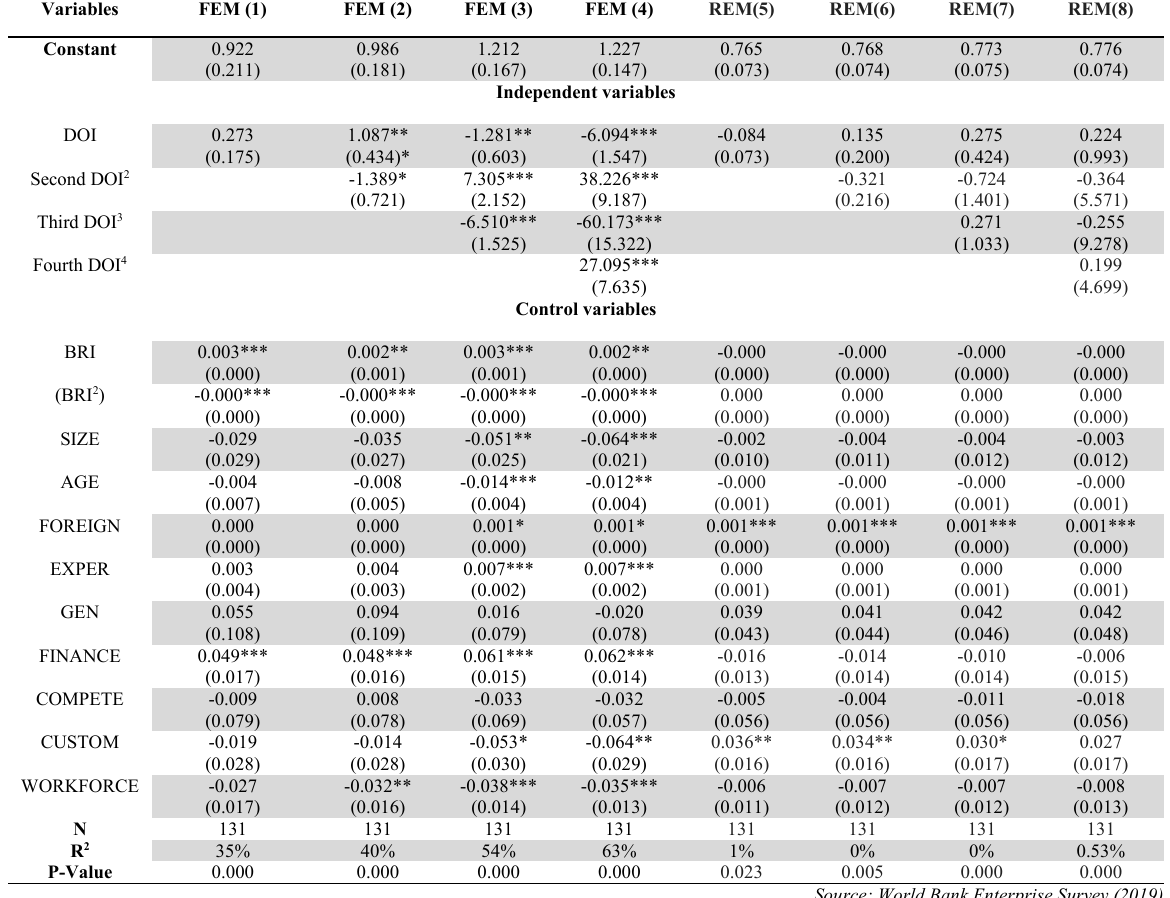
The regression results for FEM and REM models are presented in Table 3. The first four models regressed according to the FEM fixed-effects model. The 1st to 4th exponent of the independent variable DOI was sequentially added from model 1 to model 4 to examine the impact of the independent variable Internationalization level on firm performance as well as their nonlinear system. In addition to the independent variable, ten other control variables are included permanently for all four models. The REM random effects model is applied to model 5 to model 8. Regression FEM and REM results